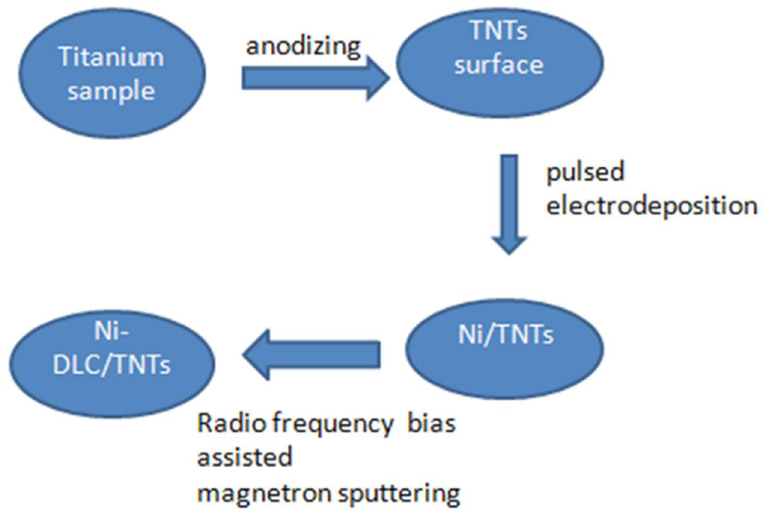
Figure 10. Steps in the sample preparation.